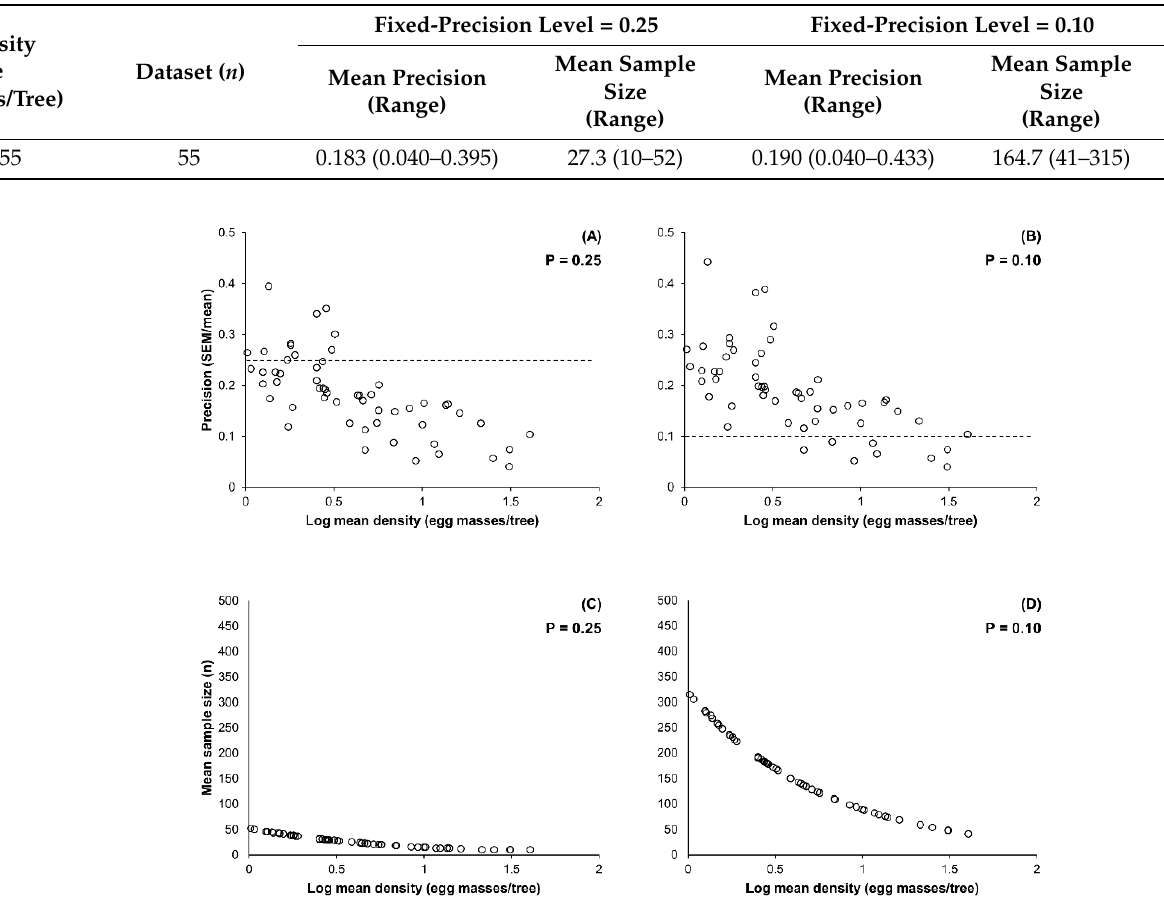
Table 2. Validation of Green’s sequential sampling plan based on resampling approach at fixed- precision levels of 0.25 and 0.10.